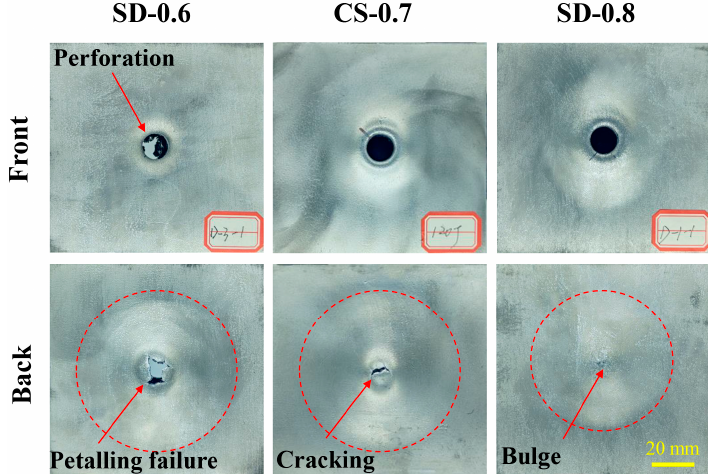
Figure 13. The failure mode of the panels of AFS with different densities.